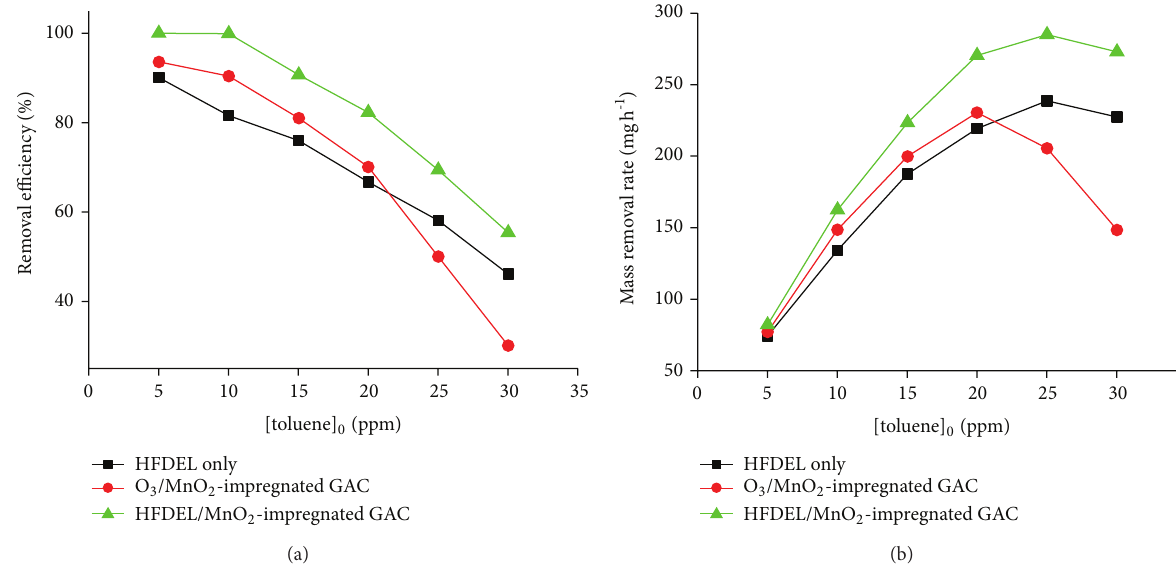
Figure 6: (a) Removal efficiency and (b) mass removal rate of toluene as a function of inlet toluene concentration by HFDEL only, O 3 /MnO 2 - impregnated GAC, and HFDEL/MnO 2 -impregnated GAC, respectively. Note that the inlet O 3 concentration in O 3 /MnO 2 -impregnated GAC is consistent with the photogenerated O 3 from HFDEL.